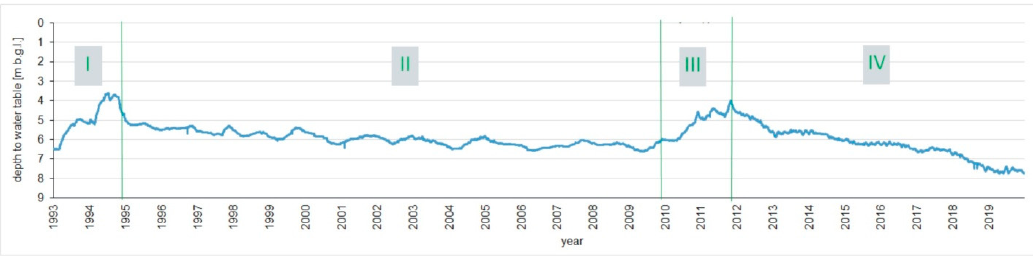
Figure 8. Water table in the shallow Quaternary aquifer in the selected research periods.